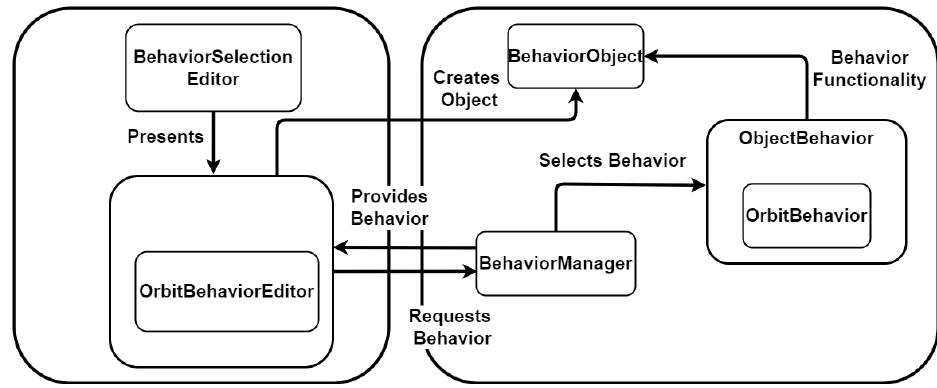
Figure 5. Object movement behavior tool’s